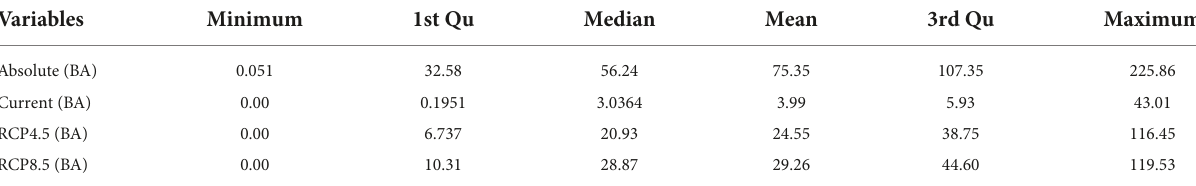
TABLE 3 Absolute basal area (m 2 /ha) and prediction of the basal area with current and future prediction of two scenarios (RCP 45 and RCP